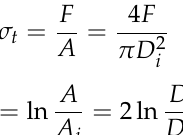
Figure 13. Deformation schematic of the necking section for the tension specimen.